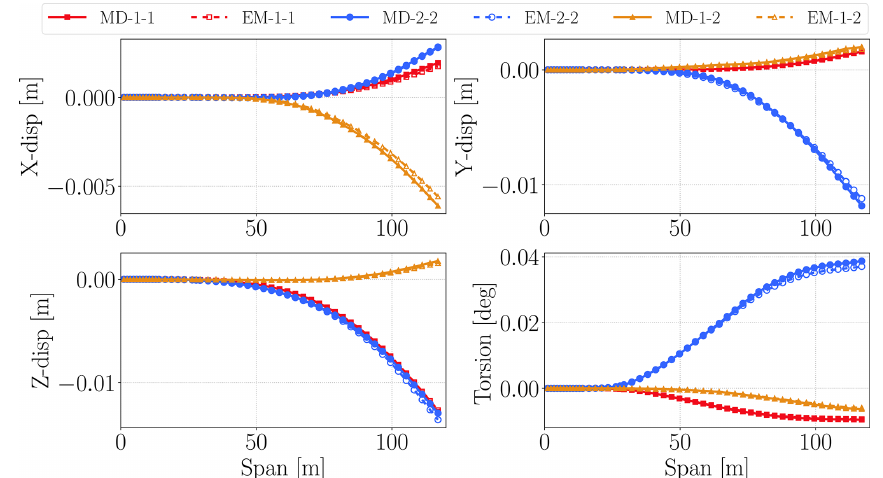
Figure 12. The first three modal derivatives and three expansion modes for the blade of the IEA 15MW reference wind turbine. The lines show the lateral and torsional displacements along the span of the blade length.